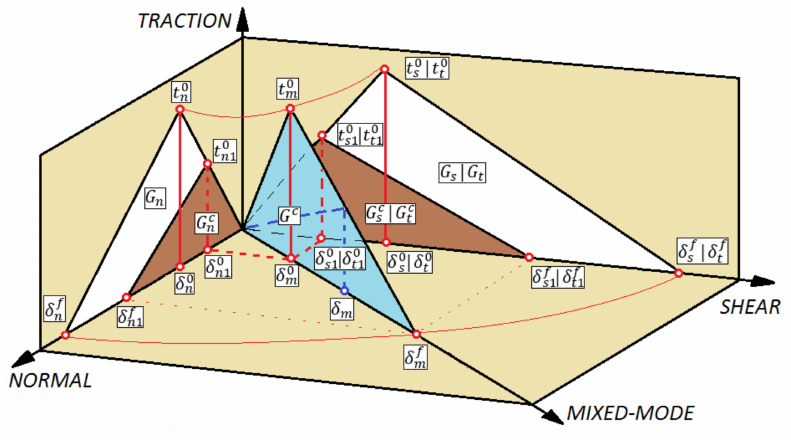
Figure 3. Traction-separation law (for cohesive